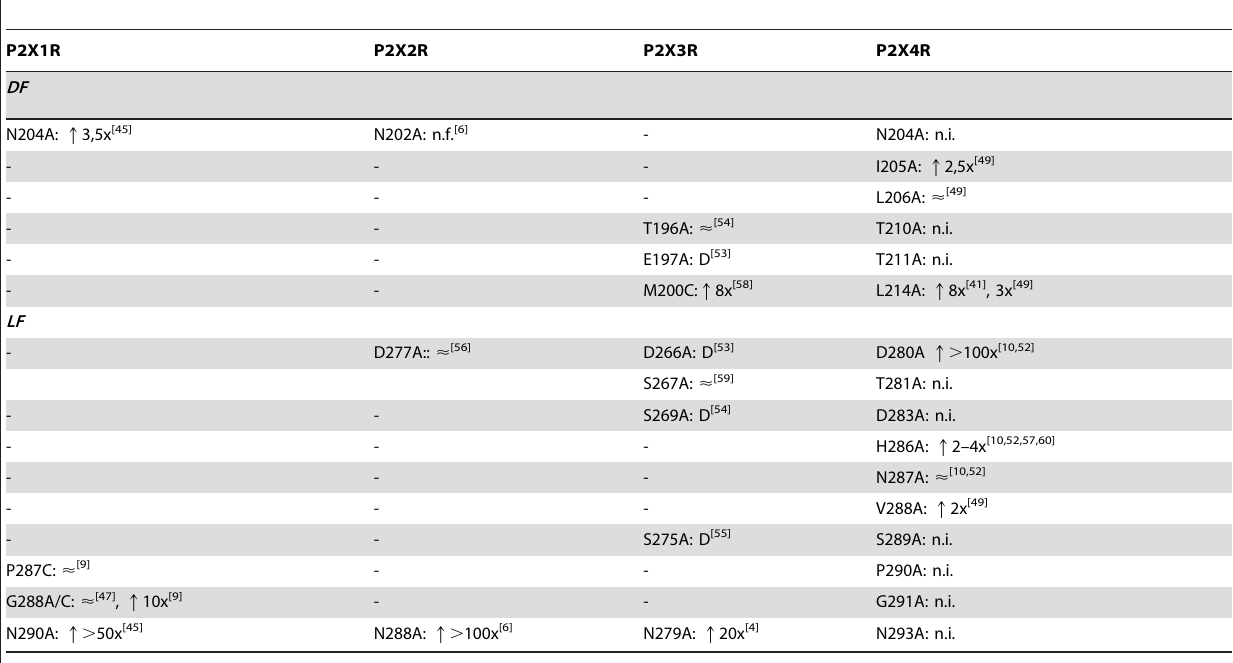
Table 1. Summary of the changes in estimated EC 50 values for ATP and changes in desensitization at the DF and LF alanine/ cysteine mutants of P2X1-4R residues from published